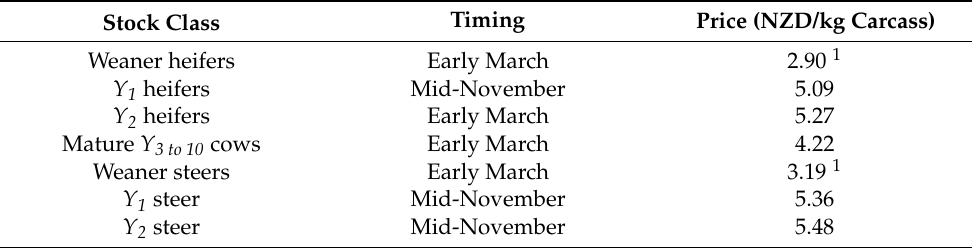
Table 4. Prices for sold cattle